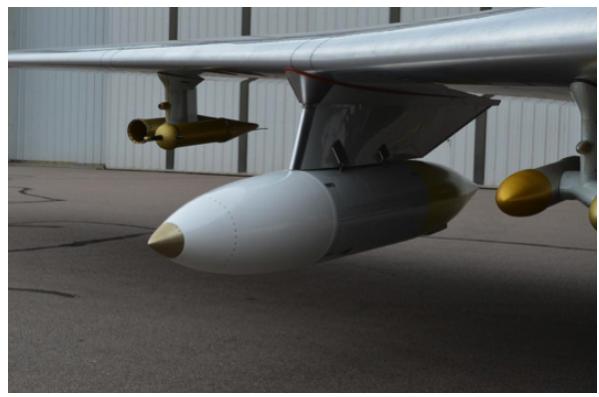
Figure 1. View of an NCAR pod mounted below the surface of the right